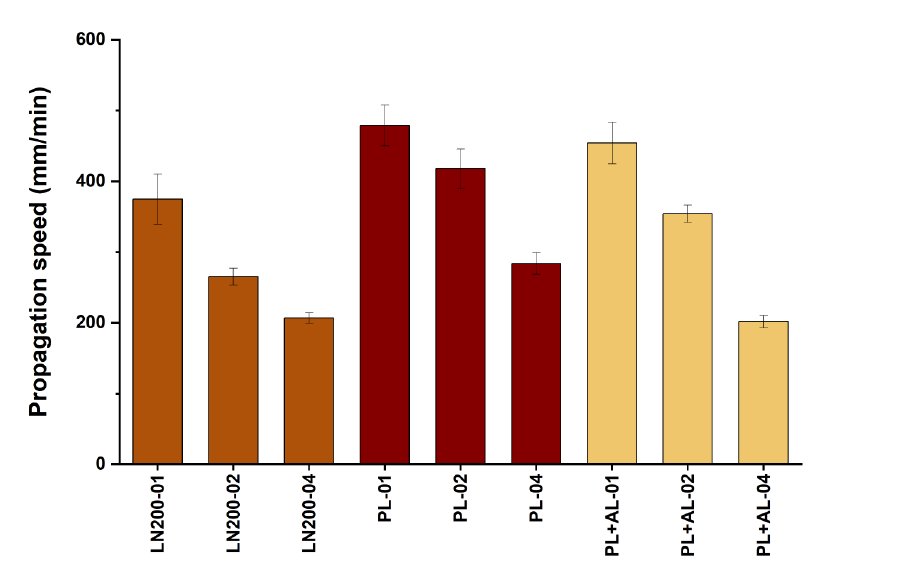
Figure 11: Propagation speed of composites with different fabric